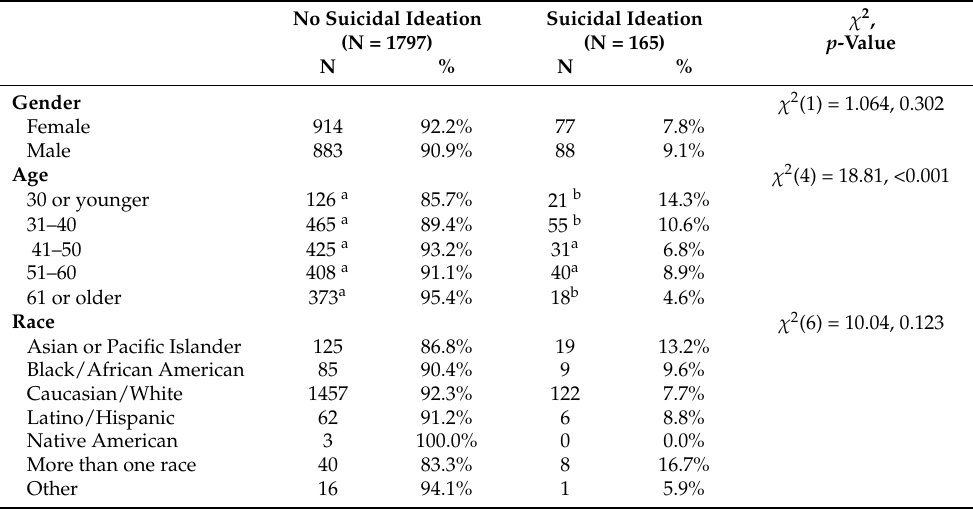
Table 1. Demographics according to endorsement of PHQ-9 suicidal ideation (N =